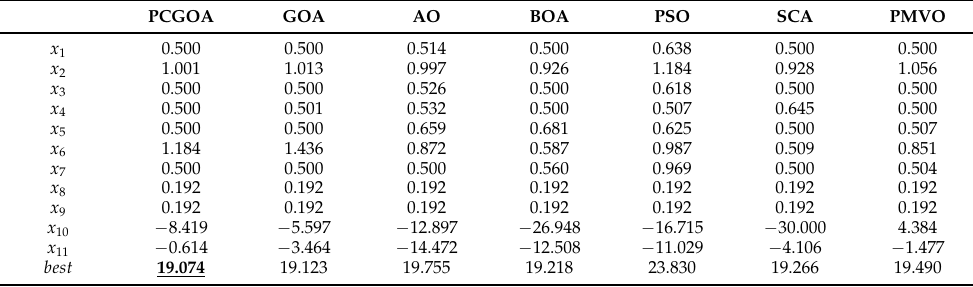
Table 8. Comparison results of each algorithm for the Car side impact design